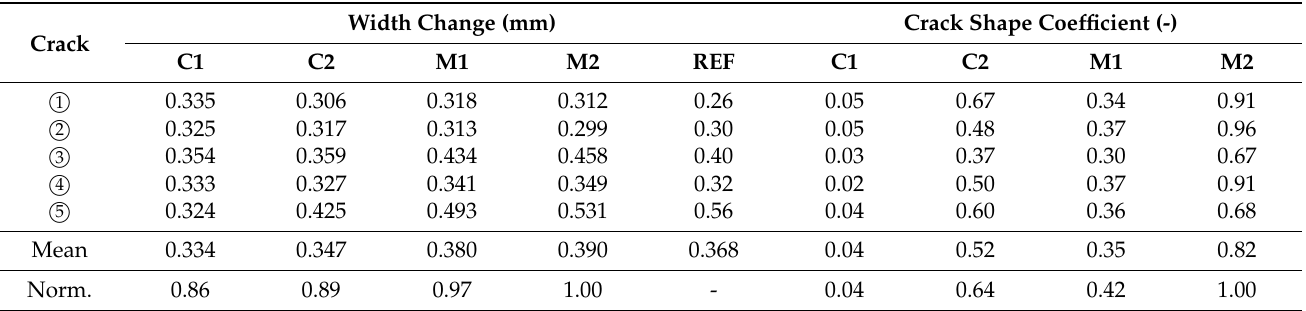
Table 6. Calculated crack widths and crack shape coefficients for all the DFOS tools in load step no. 53 and force of 200